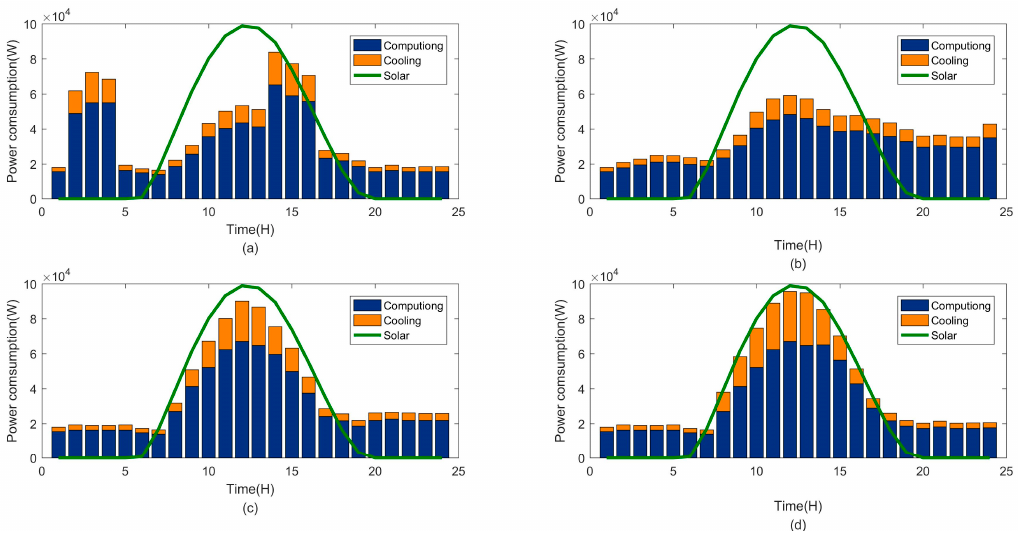
Table 5. Values of actual solar power utilized on a cloudy (rainy) day.